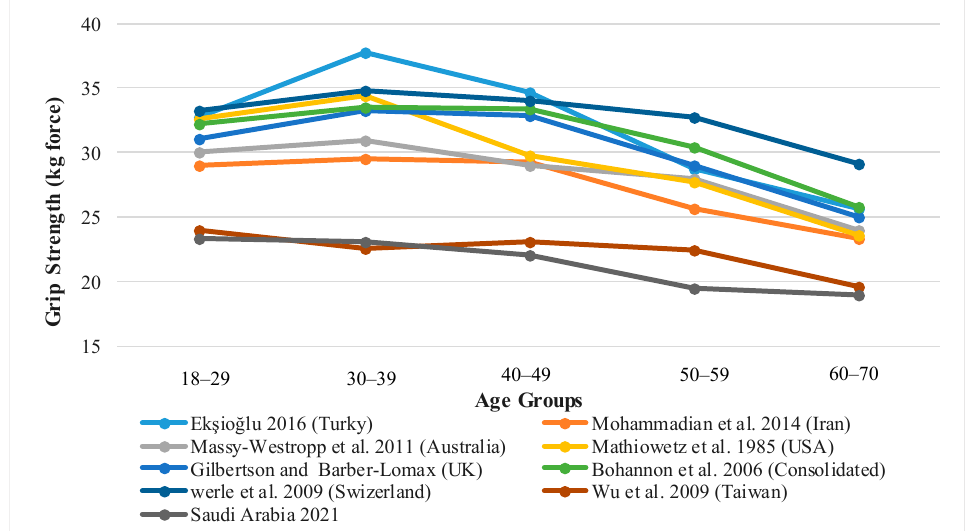
Figure 7. Female, regional reports of mean grip strength by age groups.